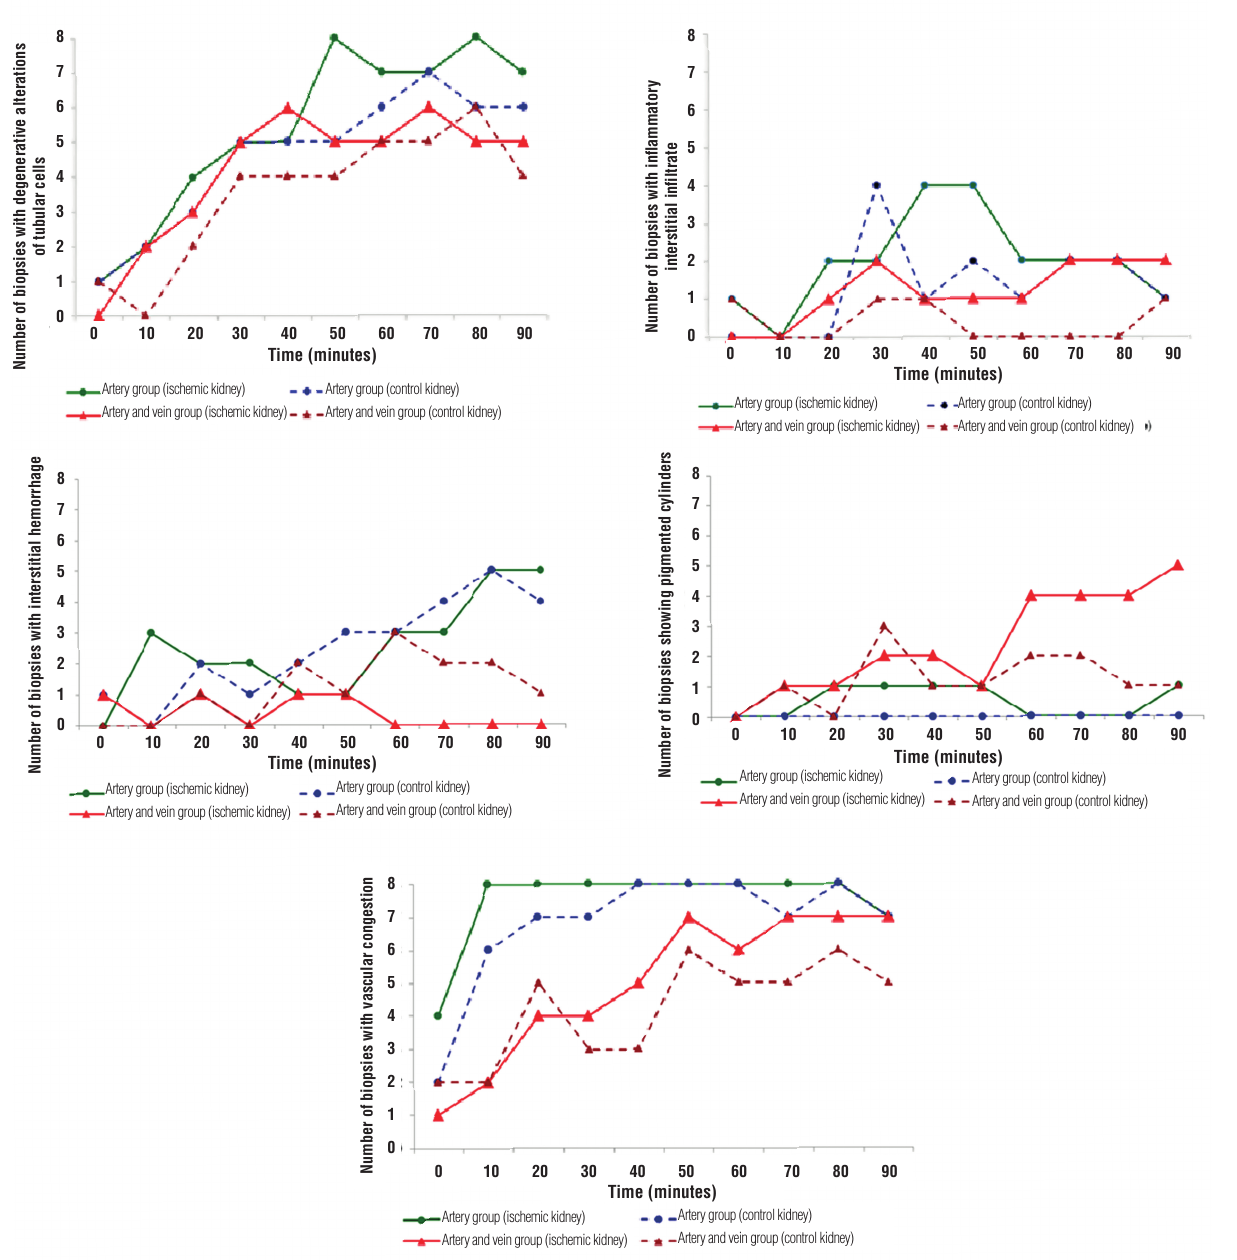
Figure 2 - From left to right, the following cellular changes are observed as a function of the ischemia and type of clamping: degenerative tubular alteration, interstitial inflammatory infiltrate, interstitial hemorrhage, pigmented cylinders and vascular